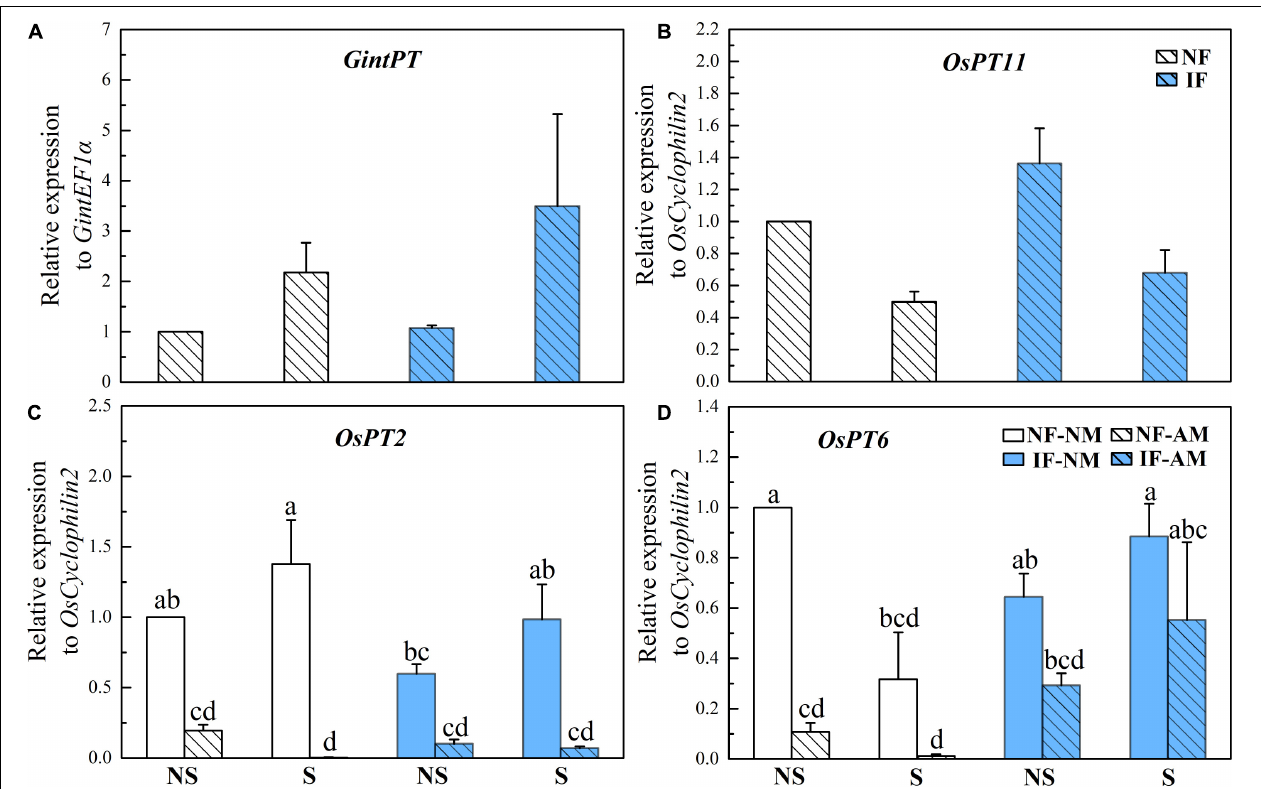
FIGURE 3 | Relative expression profiles of the P delivery marker genes from arbuscular mycorrhizal fungi (AMF) [ (A) : GintPT ] and rice [ (B) : OsPT11 , (C) : OsPT2 , (D) : OsPT6 ,] and in the mycorrhizal (AM) and NM roots under different flooding (IF, intermittent flooding, NS, non-flooding) and shading (S, shading, NS, non-shading) conditions in Exp. 2. Guinongzhan (GNZ) was used, and rice plants were harvested at the heading stage. The expressions of rice and AMF genes are relative to the expression of the rice house-keeping gene OsCyclophilin2 . Different letters above the columns indicate significant differences at the P < 0.05 level. Means and standard errors from three replicates are shown.